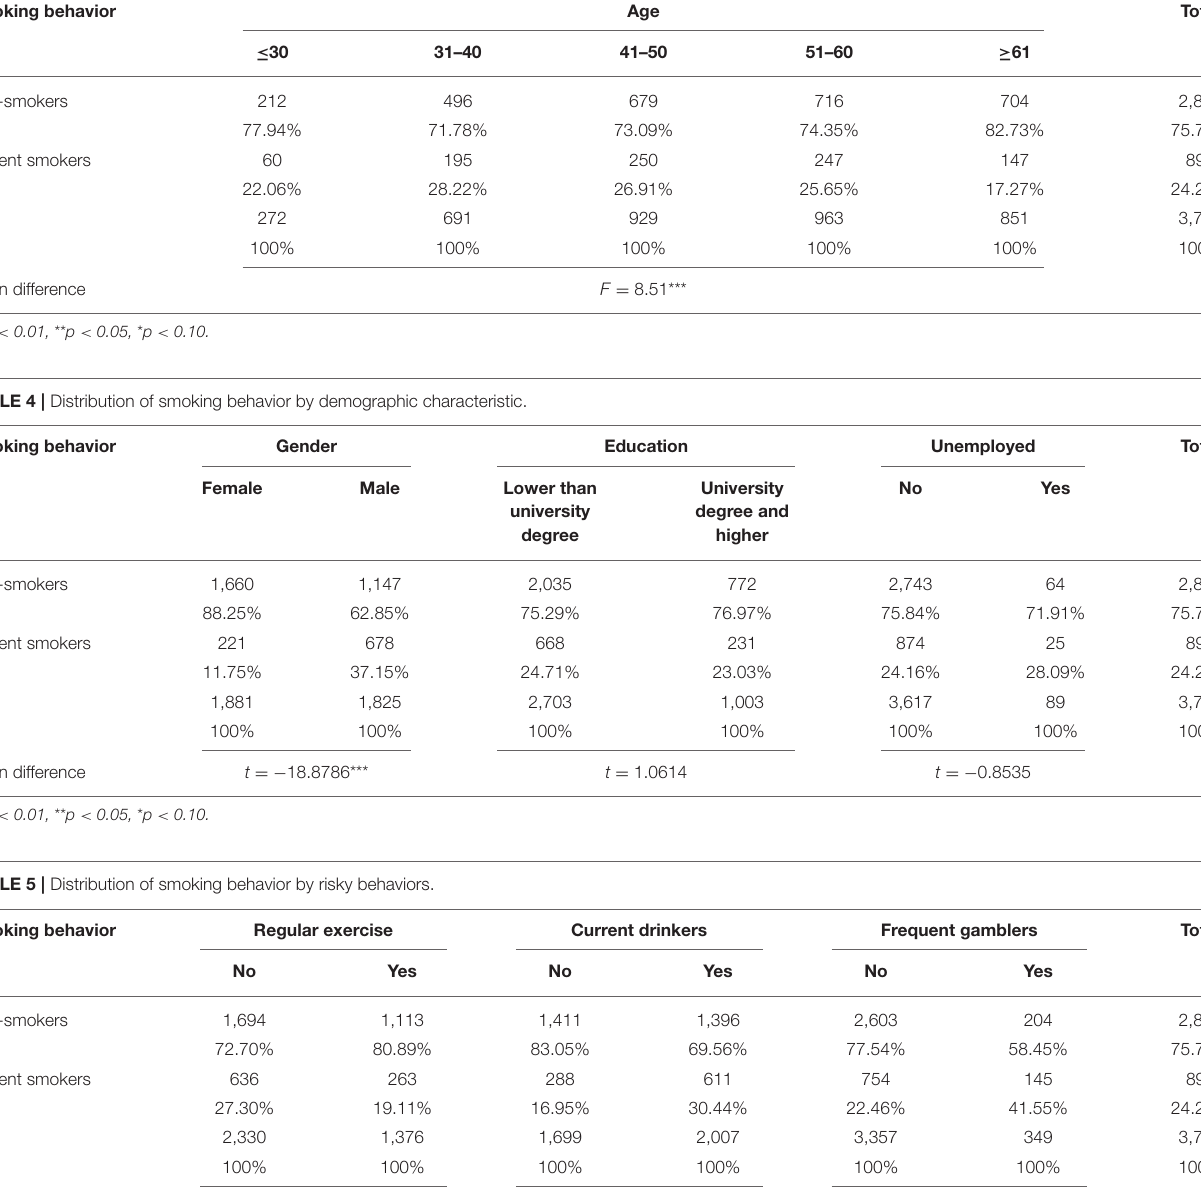
TABLE 3 | Distribution of smoking behavior by age group. Smoking behavior